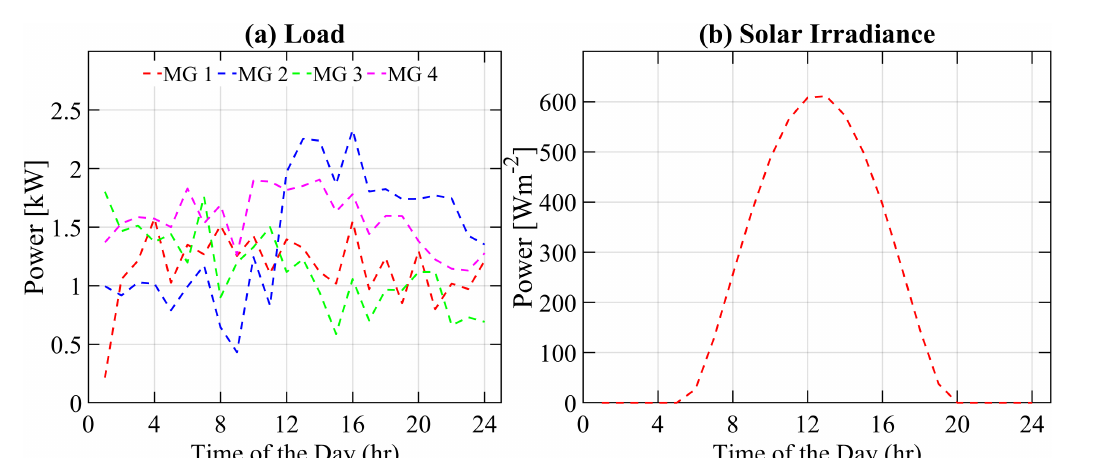
Figure 5. ( a ) Varying load demand of all microgrid under normal day condition, ( b ) Solar irradiance data used for simulation fro a complete cycle of day